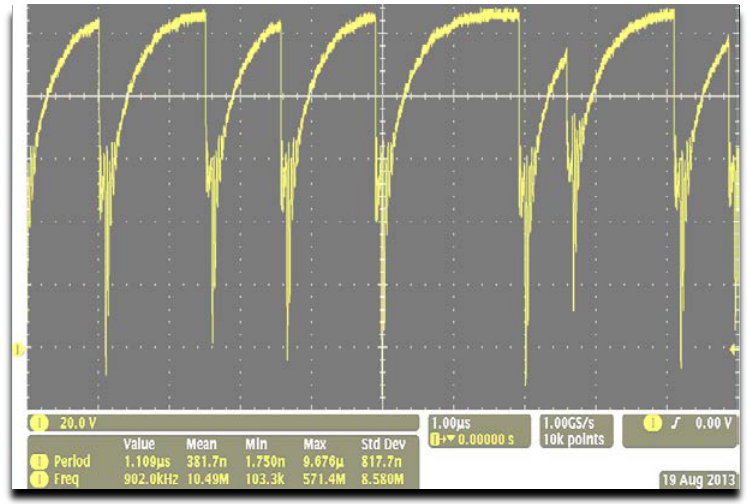
Figure 5: Normal pulse at C = 220 pF and V = 110